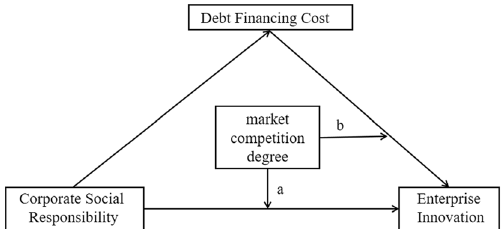
Figure 1. Conceptual framework of the